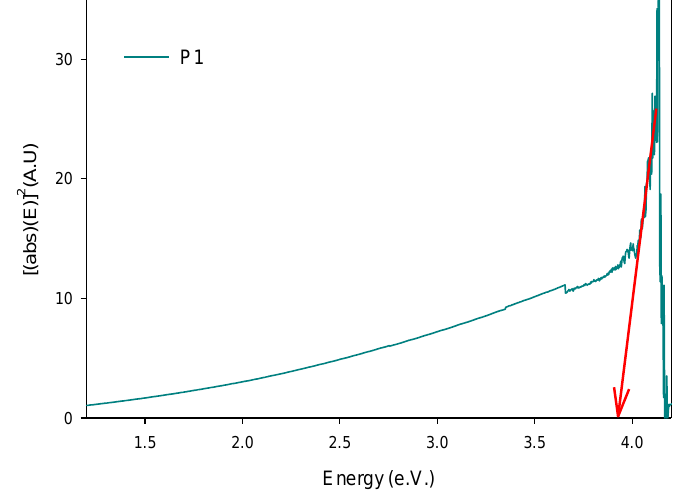
Figure 13. Plot of the visualization of the bandgap in PHUs.